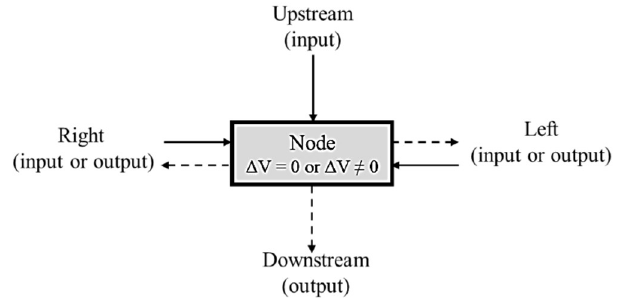
Figure 3. Input-output balance in headwork node.